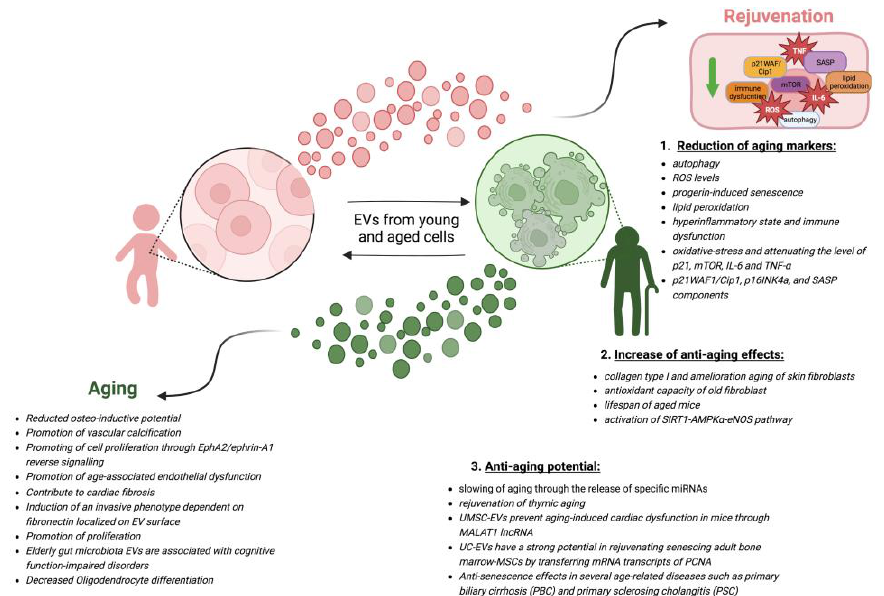
Figure 2. The role of EVs in aging. Extracellular vesicles are known to influence aging and age-related diseases. Both young and senescent cells are capable of secreting EVs. Secreted EVs from young and senescent cells can induce rejuvenation or aging in senescent and young recipient cells, respectively, as indicated by arrows. The molecular mechanisms by which EVs from young cells induce rejuvenation of old cells can be divided into 3 main groups: ( 1 ) reduction of aging markers [145,147–149,151,161], ( 2 ) increase of anti-aging effects [131,147,150,160], and ( 3 ) anti-aging potential [151,154–156,159]. The arrows between the two types of cells mean that both cells are able to secrete EVs. Relevant literature is provided for each group. Mechanisms by which EVs from senescent cells may promote aging and age-related diseases in young cells include promotion of vascular calcification, cardiac fibrosis, reduction of cell differentiation, and others. References to relevant publications on these topics are also provided [114–116,125,141–144,162]. Created with BioRender.com accessed on 20 January 2023.